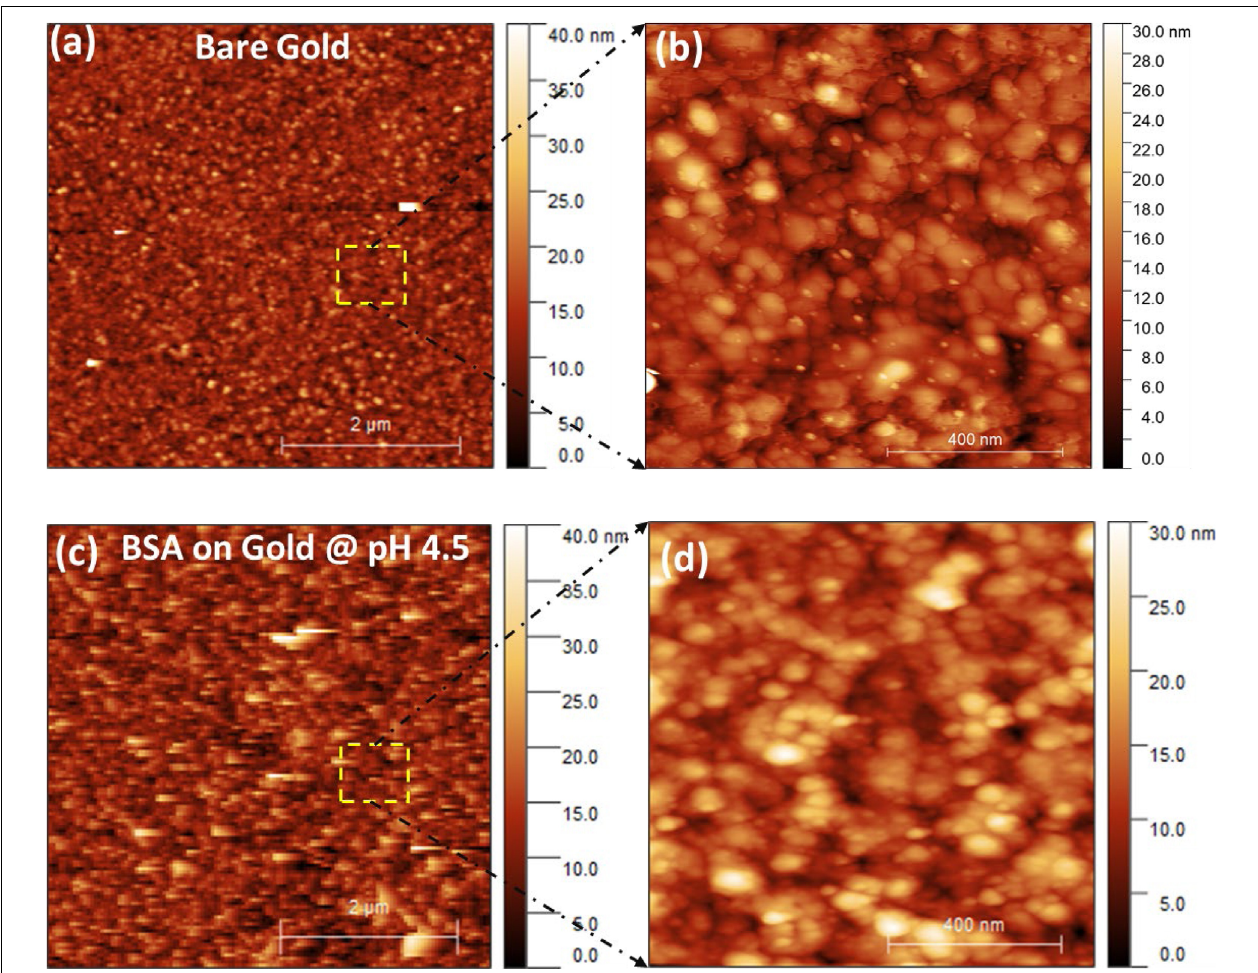
FIGURE 4 | (a) AFM images of the bare gold interface, (b) Enlarged/magnified image of bare gold interface, (c) BSA layer adsorbed at the gold interface at pH 4.5 (d) Enlarged/magnified image of BSA coated